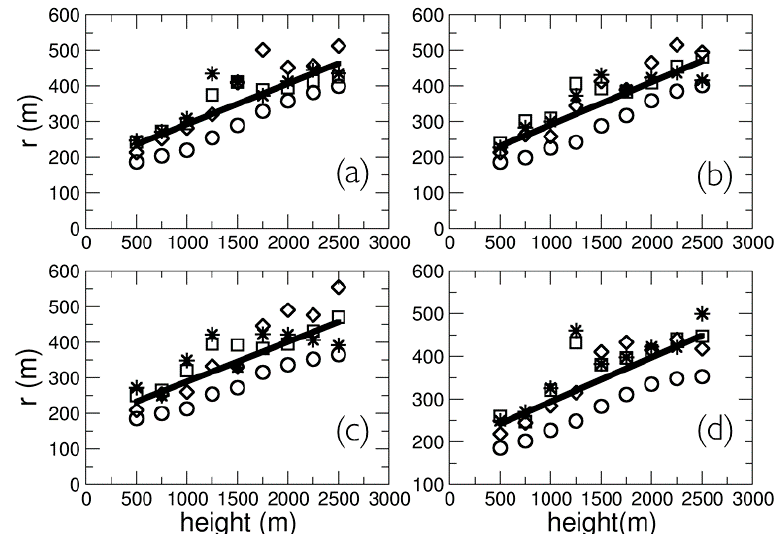
Figure 6. Radial spread against height for ( a ) 15, ( b ) 30, ( c ) 45 and ( d ) 60 min after eruption. Symbols represent vent heat fluxes of Q = 1.8 × 106 W m − 2 (circles), Q = 6.4 × 10 6 W m − 2 (diamonds), Q = 8.8 × 10 6 W m − 2 (squares), Q = 1.1 × 10 7 W m − 2 (stars). The best-line fit (see text for properties) for all the data is shown by the solid black line.